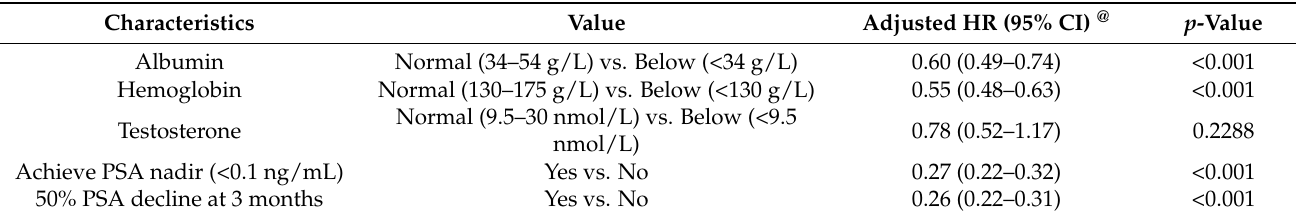
Table 4. Cox proportional hazards model of time to death by laboratory markers stratified into binary variables by lower limit of normal level (binary